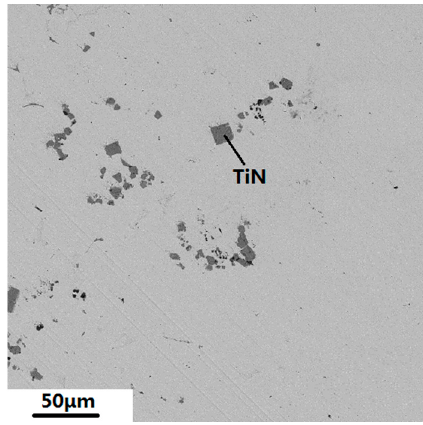
Figure 9. SEM analysis of floater steel collected from verification experiment.